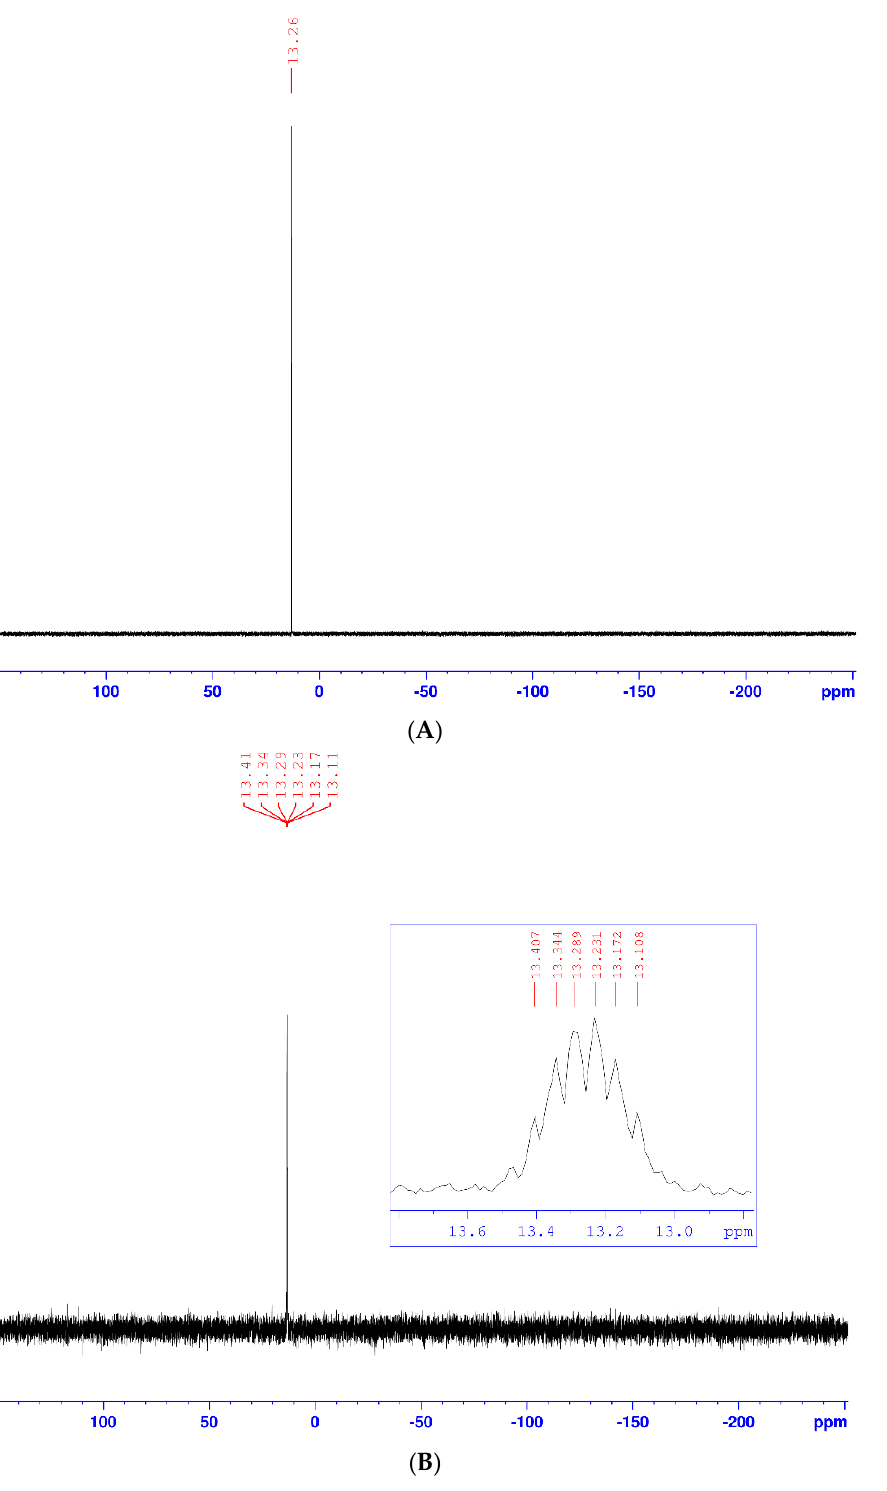
Figure 1. ( A ) Decoupled 31 P-NMR spectra of compound ( 3 ); ( B ) Coupled 31 P-NMR spectra of compound ( 3